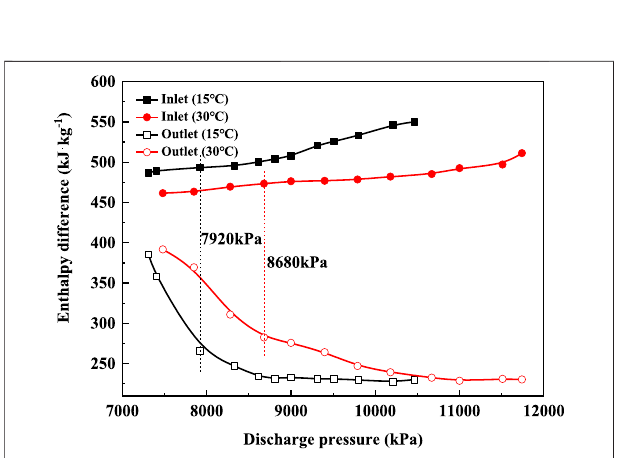
FIGURE 6 | Enthalpy variation of the gas cooler inlet and outlet at the compressor frequency of 20